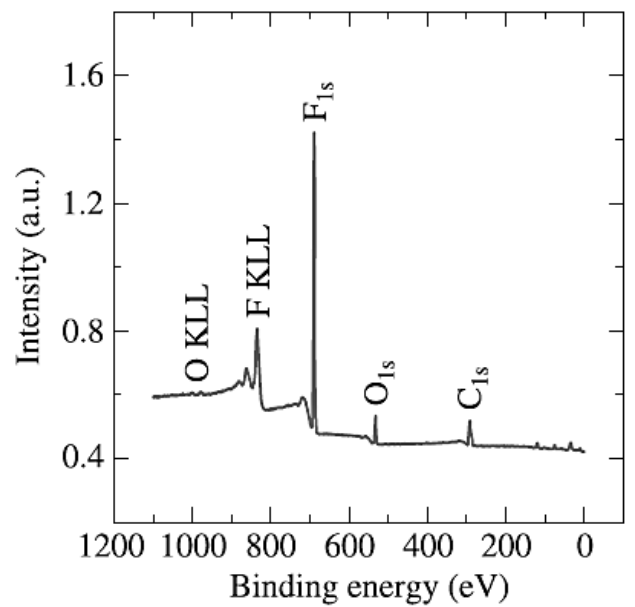
Figure 6. XPS survey spectrum of an rf-sputtered Teflon ® coating on ns-Al (Tef/ns-Al).